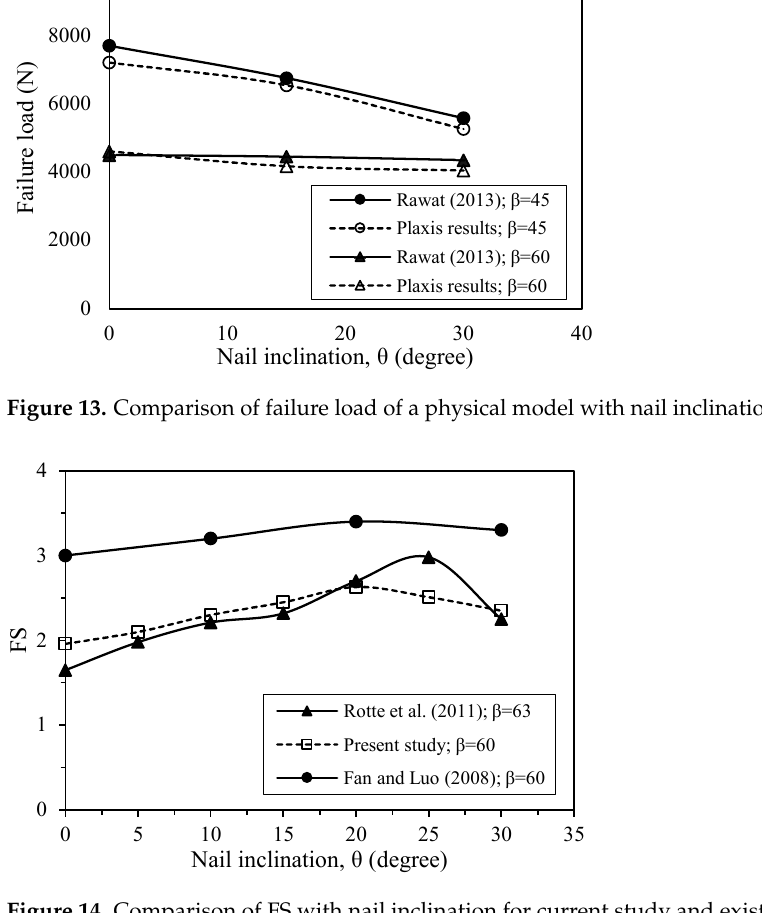
Figure 13. Comparison of failure load of a physical model with nail inclination for measured results.